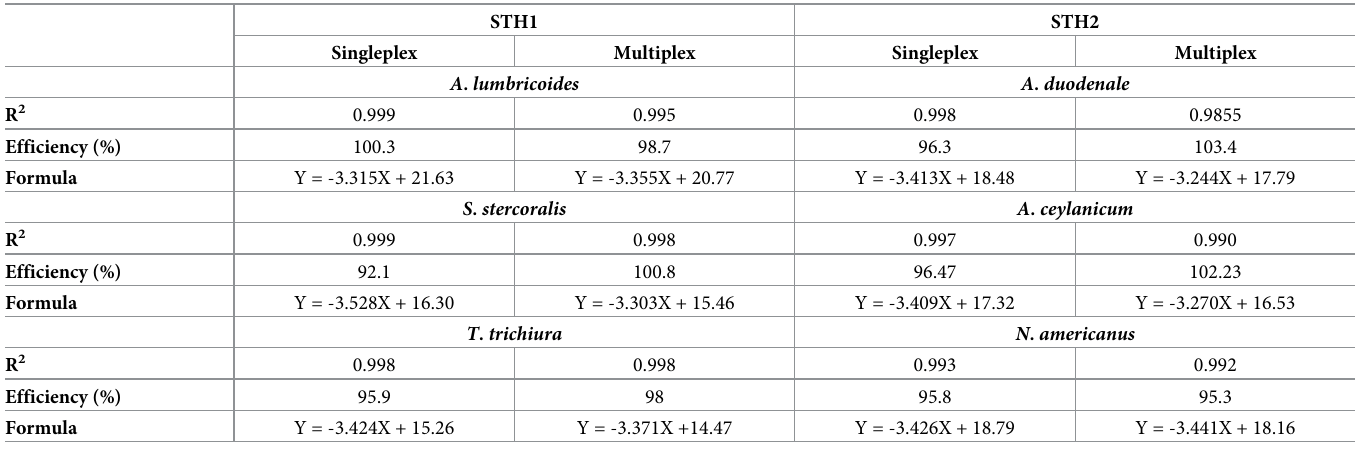
Table 2. Analytical performance of the two multiplex assays.